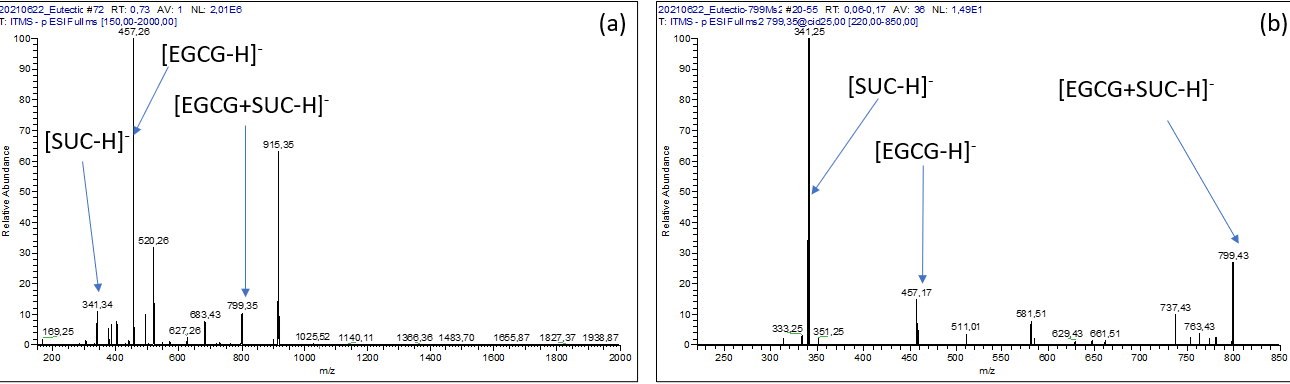
Figure 4. ( a ): ESI - MS spectrum of an EGCG–sucrose solution; ( b ): ESI - MS² spectrum of the [EGCG + SUC − H] − product ion ( m / z = 799).